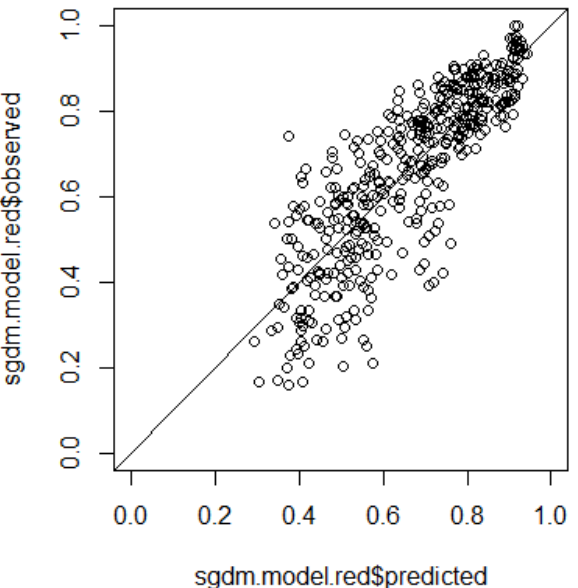
Figure 5. Plot of observed vs. predicted dissimilarities of the final model.